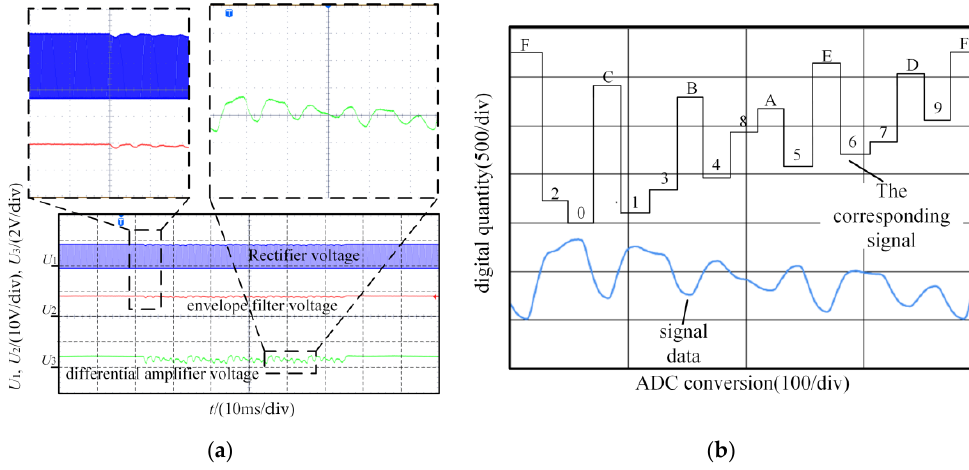
Figure 11. A 1500 baud rate 16ASK modulation information transmission diagram: ( a ) Demodulation circuit waveform; ( b ) ADC conversion voltage data diagram.